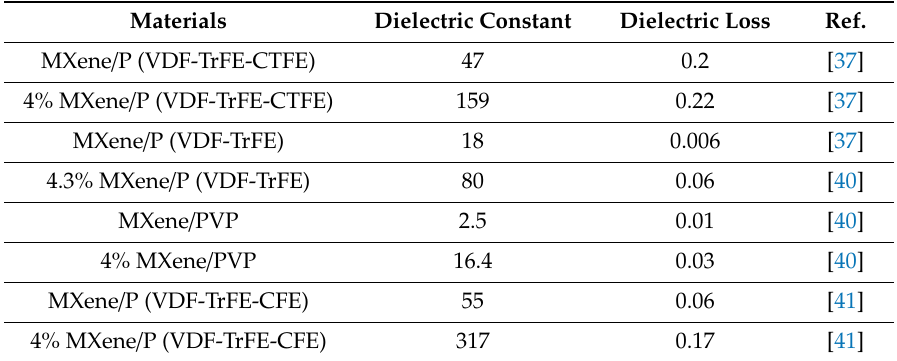
Table 4. The dielectric constant and dielectric loss of MXene with di ff erent polymer